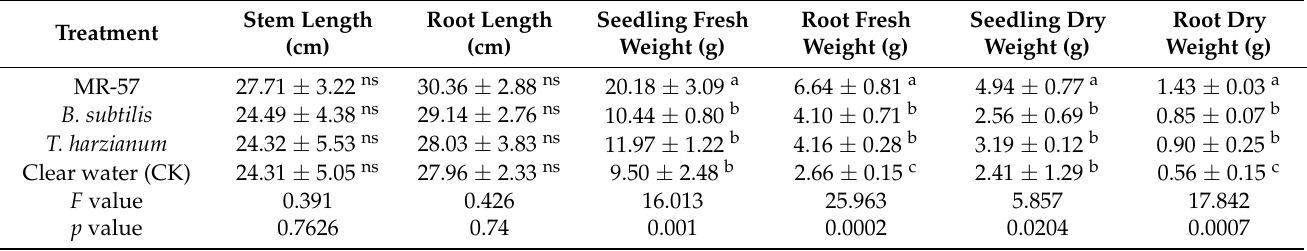
Table 3. Effects of MR-57 on promoting growth of S. divaricata